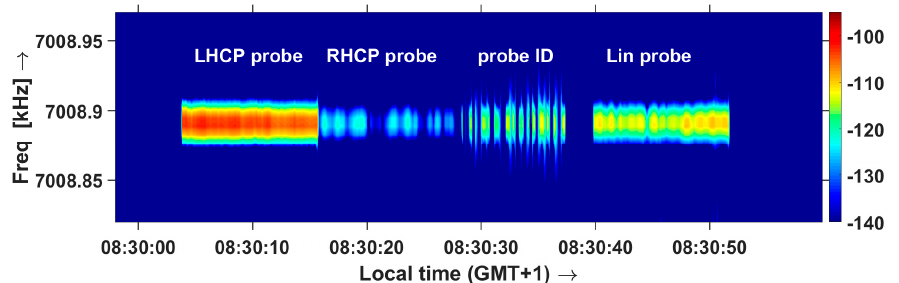
Figure 12. Spectrogram of the LHCP end RHCP waves emitted by the probe and received by the sensor on a linearly polarized antenna, during the morning Happy Hour.